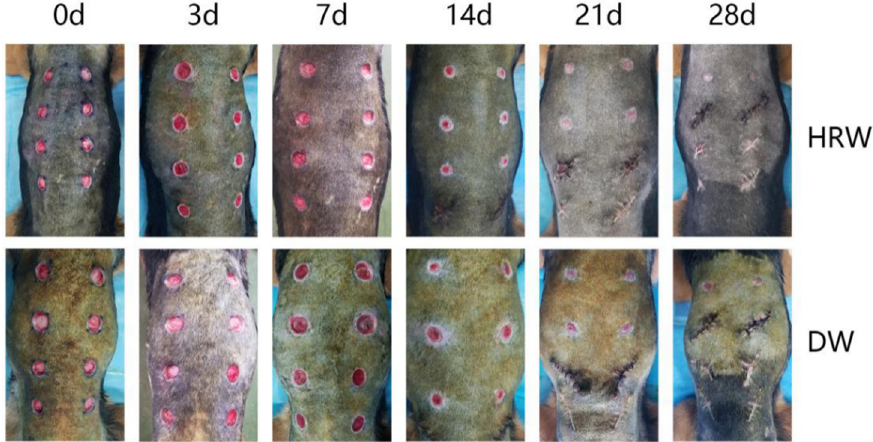
Figure 2. (HRW) Images of dogs in the experimental group at days 0, 3, 7, 14, 21, and 28 after modeling; (DW) Images of dogs in the control group at days(d) 0, 3, 7, 14, 21, and 28 after modeling. The same dog was photographed at each time point in HRW group both DW group.